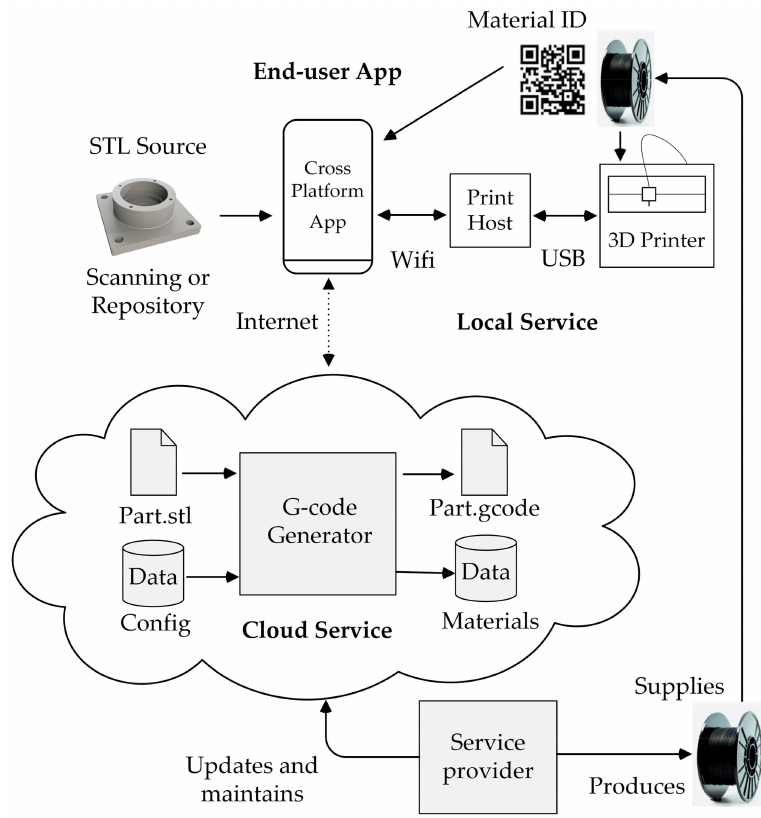
Figure 1. Integrated service